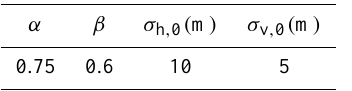
Table 2. Diffusion parameters for ship plume dispersion used by von Glasow et al. (2003) ( α ad β are best guest values).